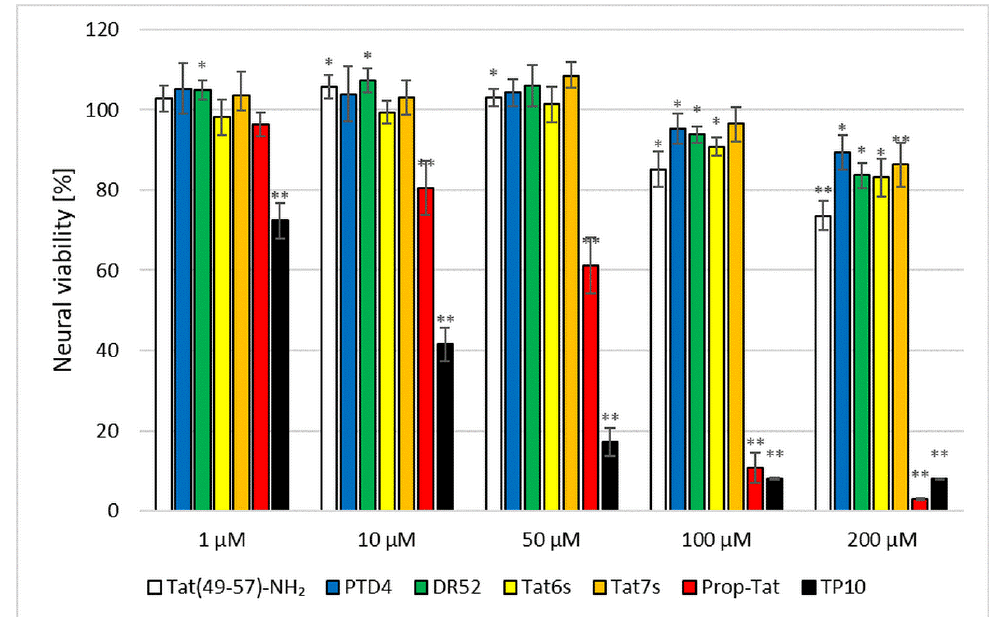
Figure 4. Experimental designs: peptide neurotoxicity ( A ), in vitro model of AIS ( B ), and peptide neuroprotection against AIS ( C ).